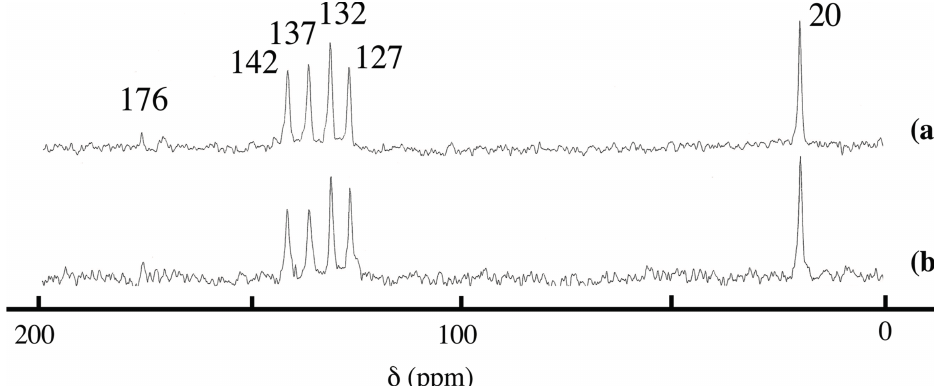
Figure 4. FT-IR spectra of ( a ) LDH(NO